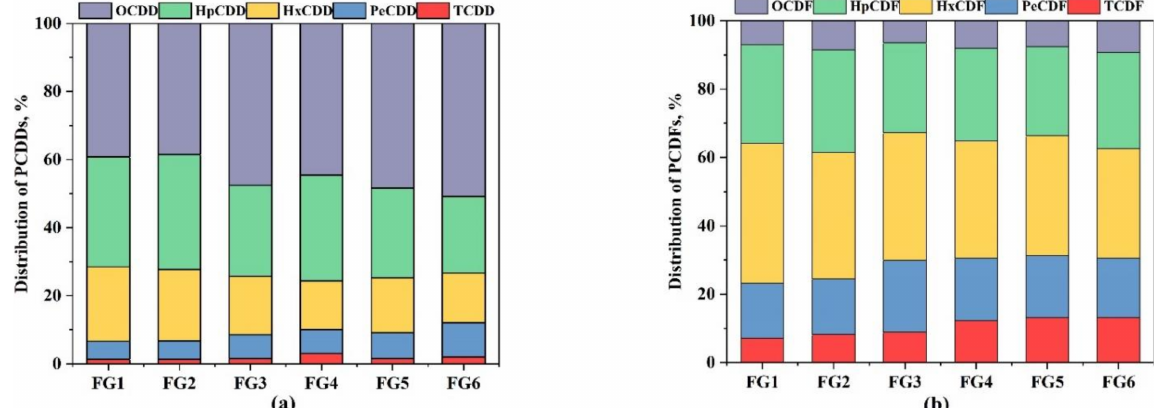
Figure 4. ( a ) Mass distribution of PCDDs; ( b ) mass distribution of PCDFs.